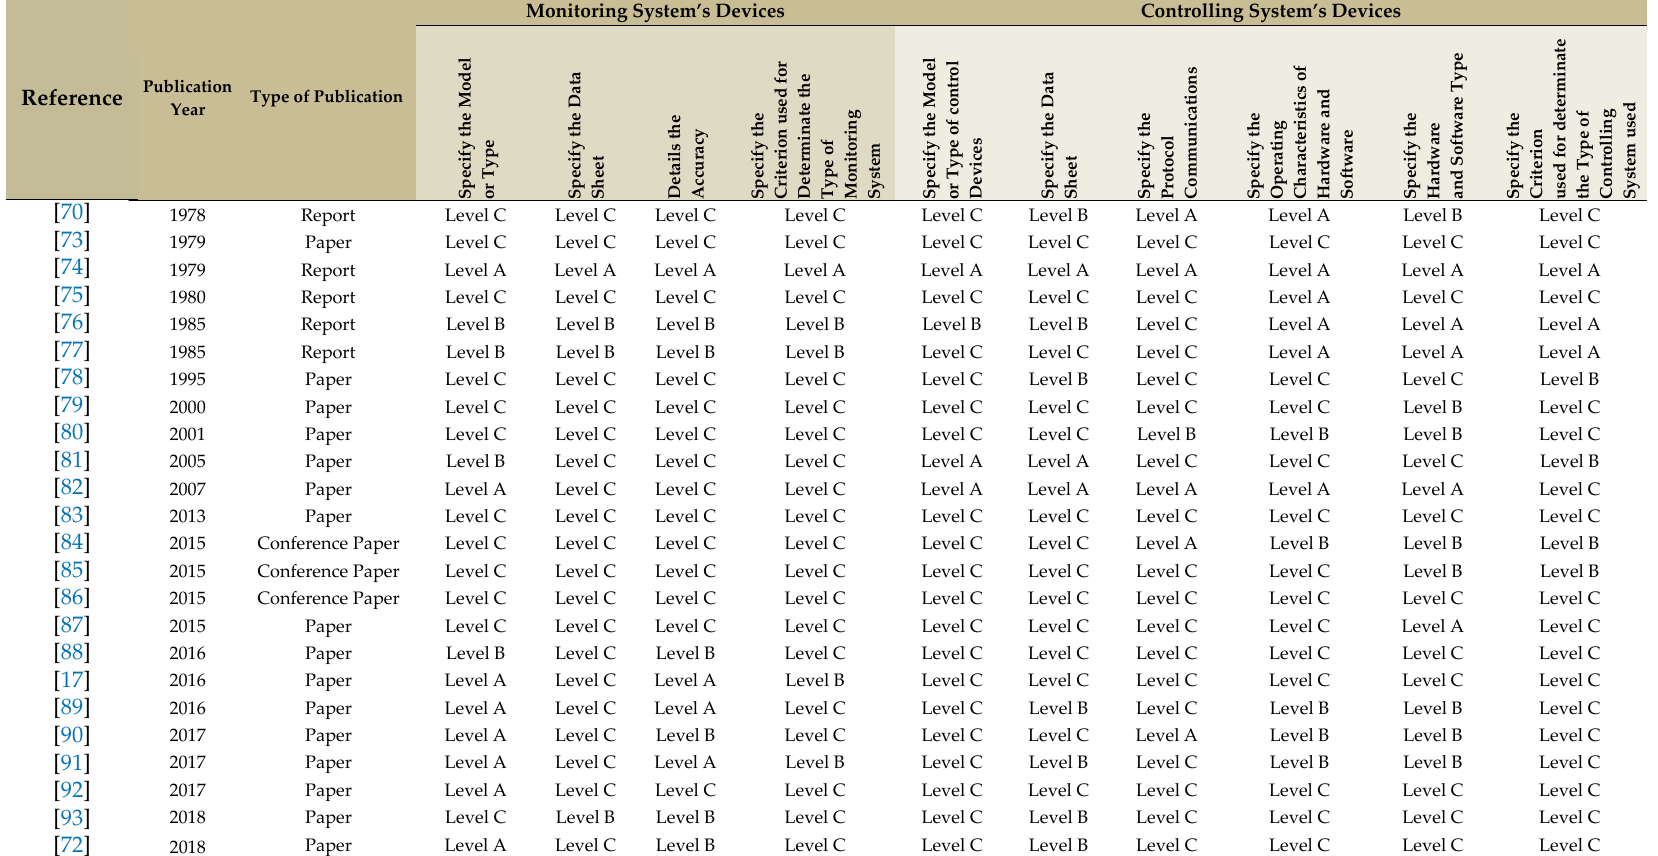
Table 12. Qualitative analysis of the specification level’s degree of the analyzed criteria for the devices, hardware, and software of MCSs used in buildings or prototypes in each publication studied.